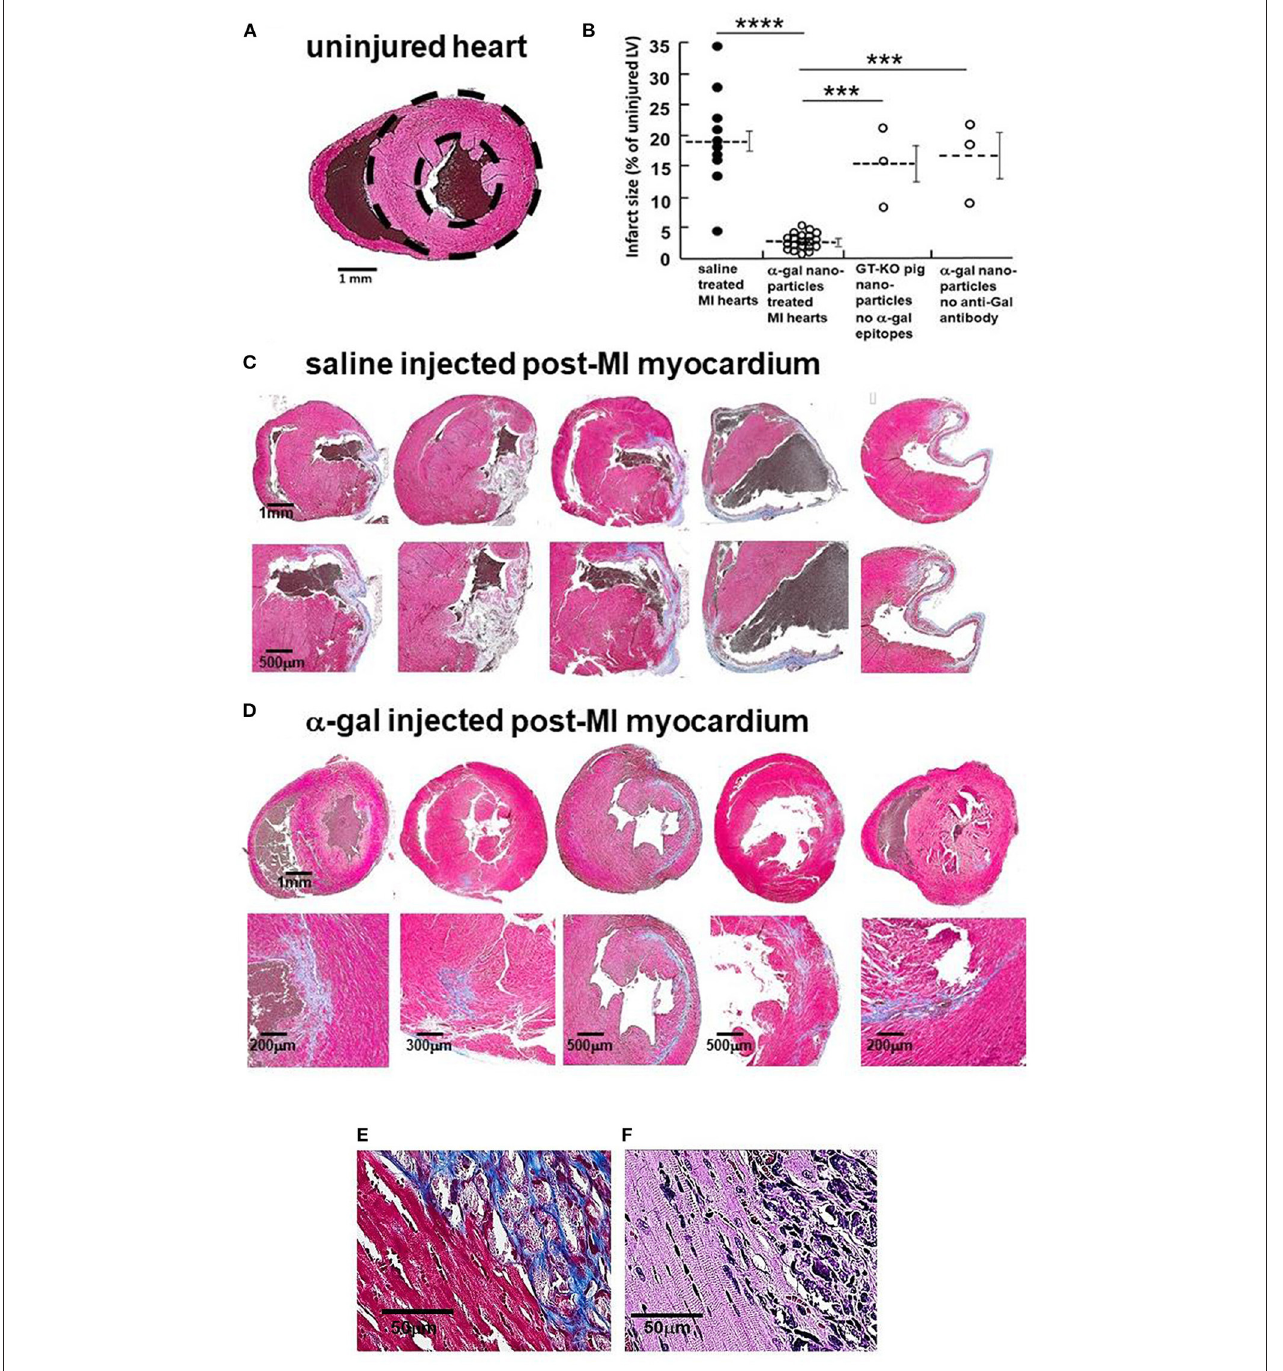
FIGURE 3 | Myocardial repair 28 days post-MI in adult mice treated with α -gal nanoparticles. (A) Normal heart- dashed circles demarcate LV (Trichrome, uninjured cardiomyocytes-red, RBCs-brown). (B) Infarcted size determined by fibrosis due to myocardial infarction, measured by planimetry and calculated as percentage, relative to the area of uninjured LV in 10 saline controls, 20 α -gal nanoparticles treated hearts, 3 hearts injected with nanoparticles lacking α -gal epitopes, and 3 hearts from mice lacking anti-Gal and treated with α -gal nanoparticles. Results are also presented as mean (dashed lines) ± SE. Horizontal solid lines indicate statistical comparisons between groups. Statistical analysis was performed by One-way ANOVA, followed by Tukey’s multiple comparison test, **** p < 0.0001; *** p < 0.001. (C–E) Trichrome staining (collagen/fibrosis stains-blue, uninjured cardiomyocytes-red, RBCs-brown). (C) Saline treated hearts (additional 5 in Supplementary Figure 1A ). Fibrosis areas magnified in lower figure of each pair. (D) α -Gal nanoparticles treated hearts (additional 15 in Supplementary Figure 1B ). Fibrosis areas magnified in lower figure of each pair. (E) Border between fibrotic tissue and healthy appearing cardiomyocytes in α -gal nanoparticles treated hearts. (F) H&E staining of E, demonstrating sarcomeric striation within cardiomyocytes of normal appearance [in (E,F) , one representative of 10 hearts with similar results].